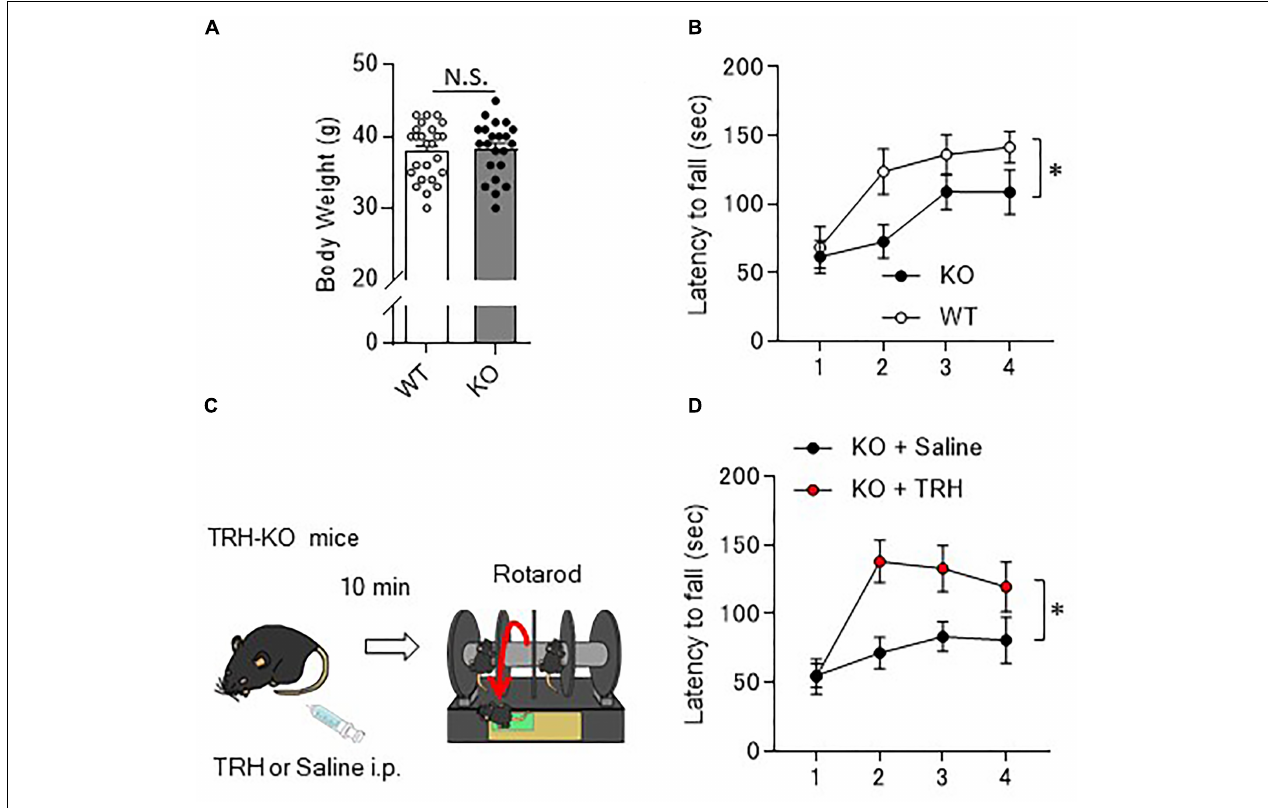
FIGURE 2 | Motor learning deficits in TRH-KO mice and the restoration by exogenous TRH. (A) No difference in the body weights between genotypes. Body weight of 10- to 14-week-old TRH-KO mice and their WT littermates were measured [WT: n = 25 (male: 14, female: 12), KO: n = 22 (male: 12, female: 10)]. N.S., not significant. (B) Graph showing the averaged results of four rotarod trials [ n = 12 (male: 8, female: 4) for both KO and WT mice], and the average time on the rod was plotted. KO, knock-out; WT, wild-type. (C) Schema showing the experimental procedure. Littermate TRH-KO mice received TRH (6 ml/kg BW, 5 mg/ml, n = 8 mice, male: 3, female: 5) or the same volume of saline ( n = 8 mice, male: 3, female: 5) intraperitoneally (i.p.). The effects of the treatment were tested 10 min after the injection using the rotarod test. (D) Results of the rotarod test. Mice were subjected to four trials. ∗ P < 0.05, as determined using repeated-measures analysis